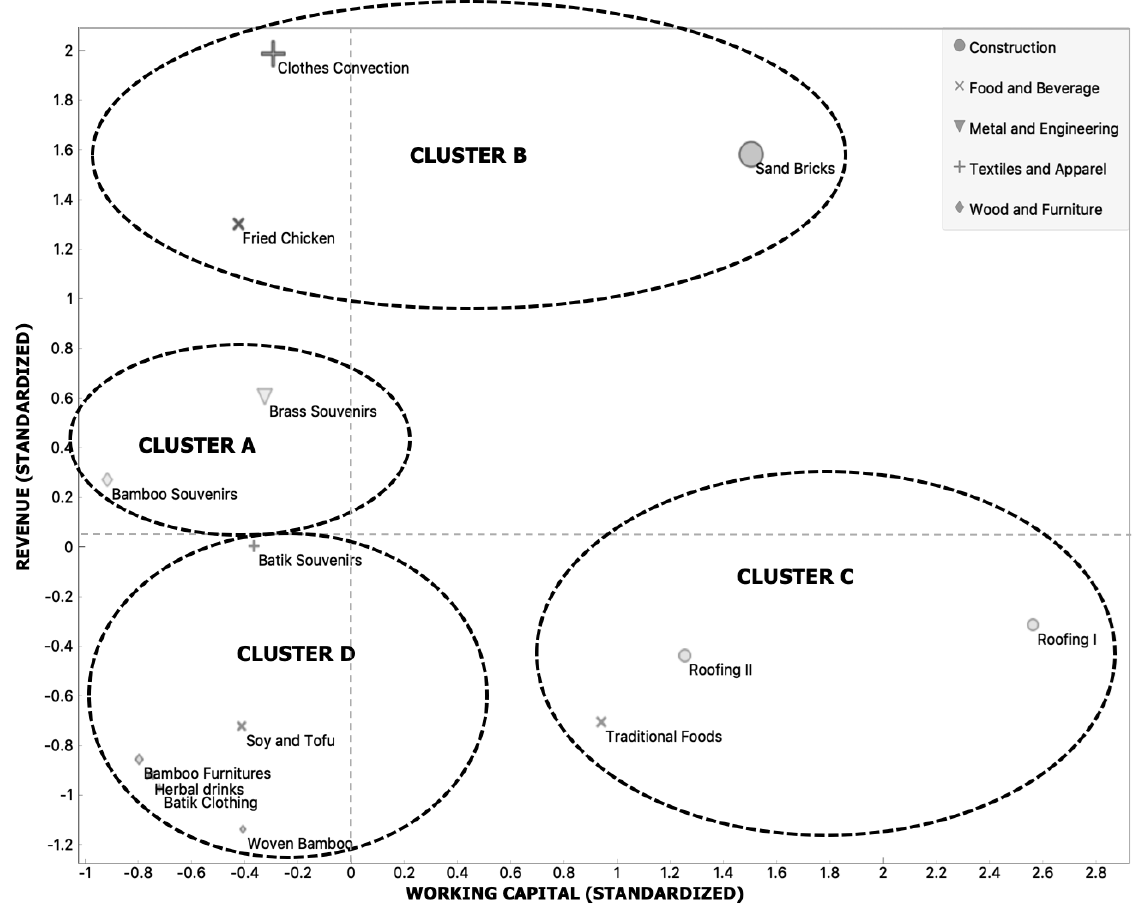
Fig. 3. Cluster Map of Industrial Centers Table 3. The average performance for each cluster in the